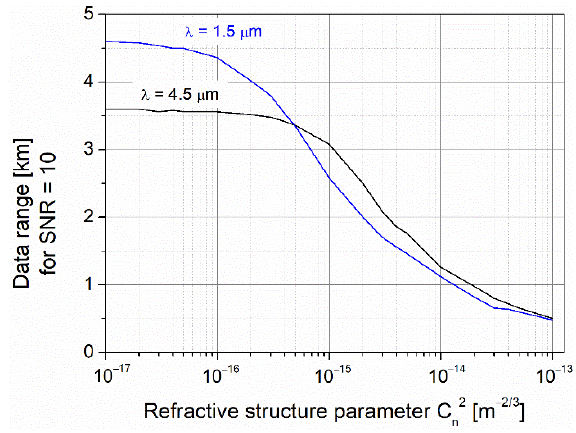
Figure 4. FSO link range vs. scintillation level for two wavelengths.